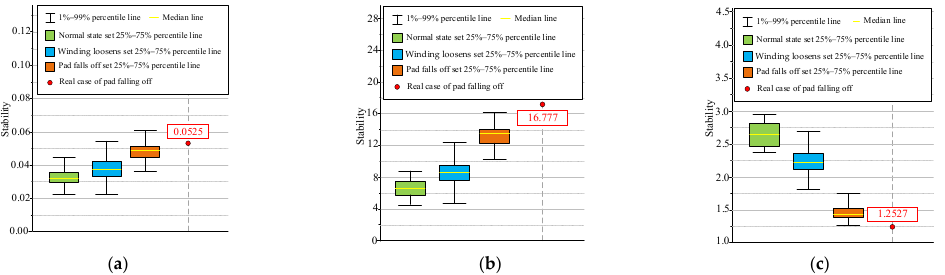
Figure 13. Comparison of various stability calculation methods under normal conditions, winding looseness and pad falling. ( a ) Euclidean distance. ( b ) Cosine distance. ( c ) Time-series spectral entropy . (1) Euclidean distance stability: the stability distribution range of the rated compres- sion force dataset is 1–99%, and the quantile value is 2.15 × 10 − 2 –4.48 × 10 − 2 . In comparison, the overall trend of the stability distribution of the winding looseness fault is not obvious, and the 1–99% of quantile value is 2.13 × 10 − 2 –5.45 × 10 − 2 ; the stability of the end pad falling samples is 1–99%, and the quantile value is 3.61 × 10 − 2 –6.05 × 10 − 2 ; and the stability of the actual pad falling fault case is 5.25 × 10 − 2 . Therefore, the numerical distribution interval of the stability calculated by using this algorithm is relatively large, and it is unable to dis- tinguish the end pad falling fault. (2) Cosine distance stability: the difference between the rated compression force da- taset and the winding looseness dataset under the algorithm is not significant. The stabil- ity distribution ranges are 4.43–8.82 and 4.59–12.27 in the range of 1–99%, respectively. The stability of the end pad falling samples is 10.18–16.22 in the range of 1–99%, and the stability of the actual pad falling fault case is 16.7773. Similar to the Euclidean distance stability, the cosine distance stability cannot distinguish the end pad falling fault. (3) Time-series spectrum entropy stability: the algorithm calculates the stability from the distribution uniformity of the spectrum signal energy. The stability value of the end pad falling samples is 0.41–1.11, which is lower than the 1% quantile line of the other two types of datasets. The stability calculation results of the rated compression force dataset and the winding looseness dataset are 2.38–2.89 and 1.22–2.53, respectively. It can be seen that this method is effective in distinguishing the end pad falling fault. To sum up, compared with the Euclidean distance and the cosine distance, the time- series spectrum entropy stability algorithm can ensure that the value of V of the end pad falling fault is outside of the 1–99% quantile line of the two datasets, achieving the identi- fication of this fault. 5.3. Samples Data Distribution of 500 kV Transformer in Operation The time-series spectrum entropy stability algorithm can effectively distinguish winding looseness and pad falling. However, the distribution range of the stability values of large transformers in operation is different from that of the small transformers used for fault simulation in this paper. Therefore, this section further adds a group of acoustic data of 500 kV transformers in operation of the power grid under normal operating conditions to delimit the normal range of stability for the site sample set. This dataset comprises 324 groups of acoustic data of 162 transformers in 24 substations of 500 kV in China in two periods, and the stability statistics of the 324 groups of acoustic data are determined using statistical methods. As is shown in Figure 14, the time-series spectral entropy of this group of data pre- sents a log-normal distribution with a mean value of 2.293 and a variance of 9.457 × 10 − 2 . The sample distribution range is mainly between 1.5321 and 3.1130. So, 1.5321 can be de- termined to be the warning threshold. The value of the real case of pad falling in this paper